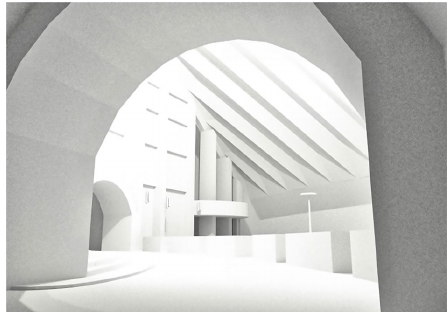
Figure 6. View from the presbytery area towards the nave